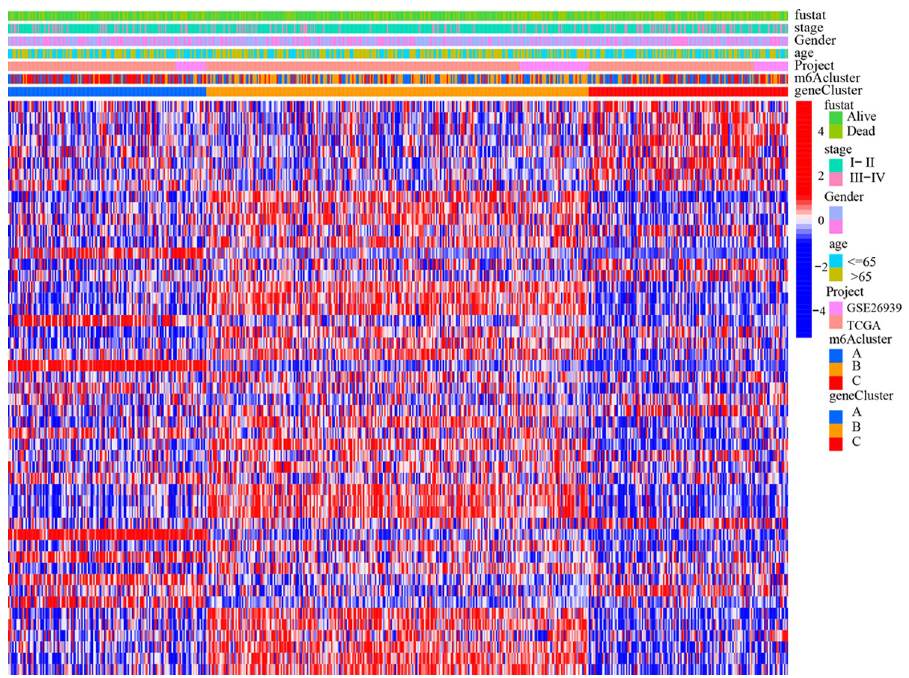
Fig 10. Gene cluster heatmap different clinical features. m 6 A cluster, clinical characteristics and distribution of m 6 A modified genes in gene cluster.